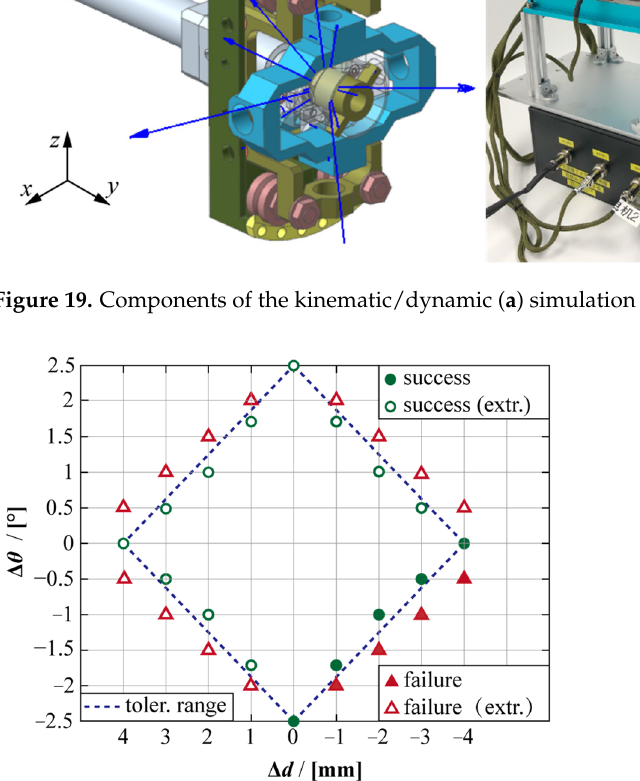
Figure 20. Kinematic results of tolerance range of the docking mechanism. Δ d represents the two linear deviations, Δ θ represents the three angular deviations, the dashed line represents the estimate tolerance range, the circles represent successful docking, and the triangles represent failed docking. Empty symbols are considered according to the central symmetry of structure to be extrapolated results.